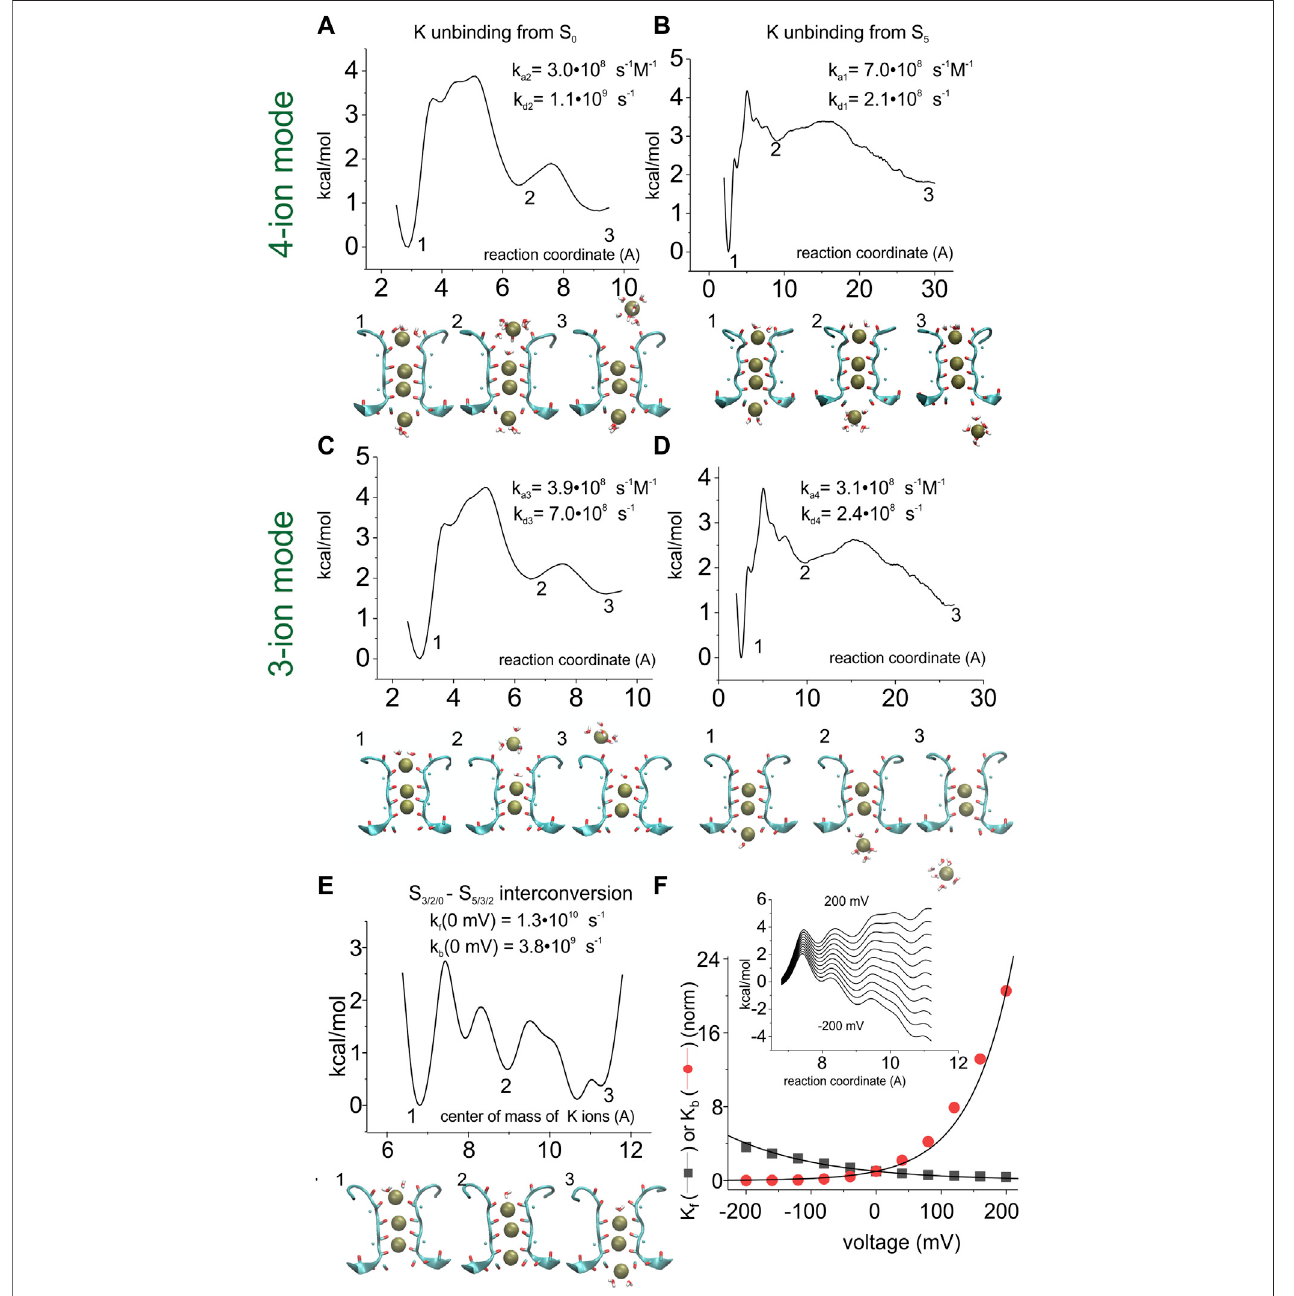
FIGURE5| Assessment oftheenergy pro fi les and kineticrateconstantsfortheK + permeation kineticmodel. Energy pro fi les wereassessed byusing theadaptive biasingforce(ABF)1DmethodfortheK + unbindingfromS0intotheextracellularsolution(Awhenstartingfromafour-ioncon fi guration,andCwhenstartingfromathree- ion con fi guration of the SF), from S5 into the intracellular solution (BD), and for the interconversion of the three K + ions inside the SF (E) . In (A) and (C) , the reaction coordinate is the distance between the most extracellular K + ion and the center of mass of the carbonyl oxygens forming site S1. In (B) and (D) , the reaction coordinate is the distance between the most intracellular K + ion and the center of mass of the carbonyl oxygens forming site S4. In (E) , the reaction coordinate is the distance between the center of mass of the three K + ions and the center of mass of the carbonyl oxygens of residue 79. (F) inset : energy pro fi le for the 3-K + ion con fi gurationoftheselectivity fi lter,plottedasinpanelEbutwiththeadditionoflinearelectrostaticenergyofvariableamount(correspondingtopotentialdifferencesfrom -200to+200 mV).ComparedtopanelE,onlythepartoftheenergypro fi legoingfromcon fi gurationS3/S2/S0(energywell#1)tocon fi gurationS5/S3/S2(energywell#3) is reported. Main plot: forward and backward rate constants (K f and K b in the scheme of Figure 4 , respectively) as a function of voltage, assessed from the energy pro fi les shown in the inset, using Eq. (28) . The numbers associated with certain wells in the energy pro fi les de fi ne the con fi guration shown below the graphs.